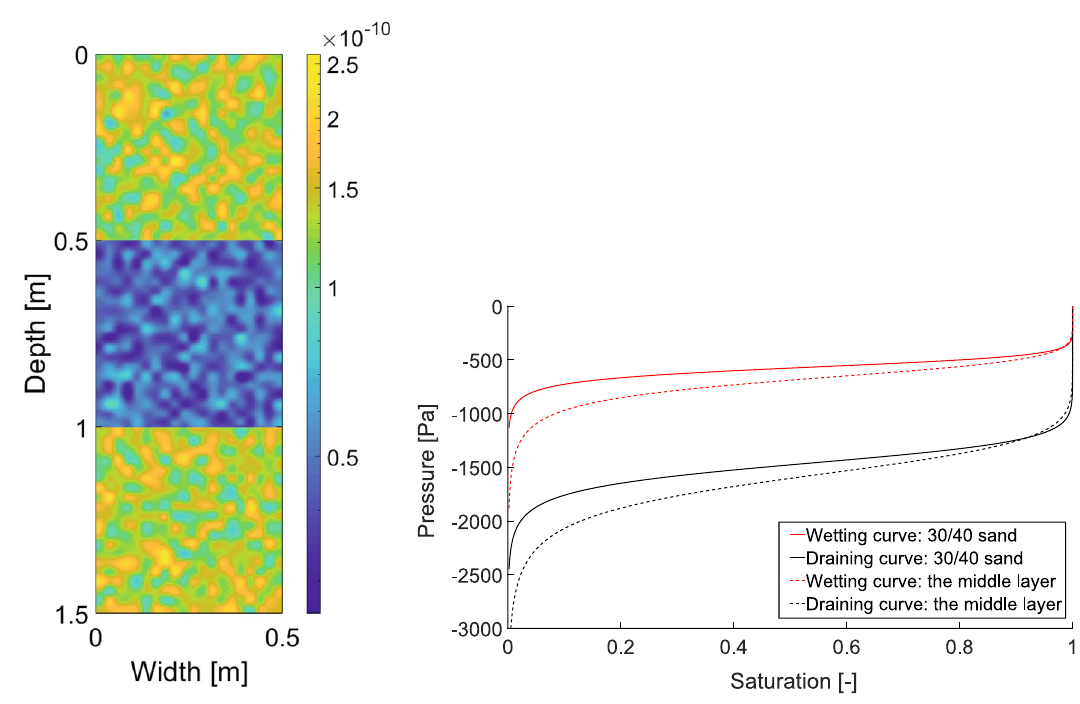
Figure 7. Reproducing the flow across layers of porous media with different characteristics. Left panel: The distribution of the intrinsic permeability. The values of intrinsic permeability are colour-coded according to the colour bar on the right. Right panel: The retention curves of the respective